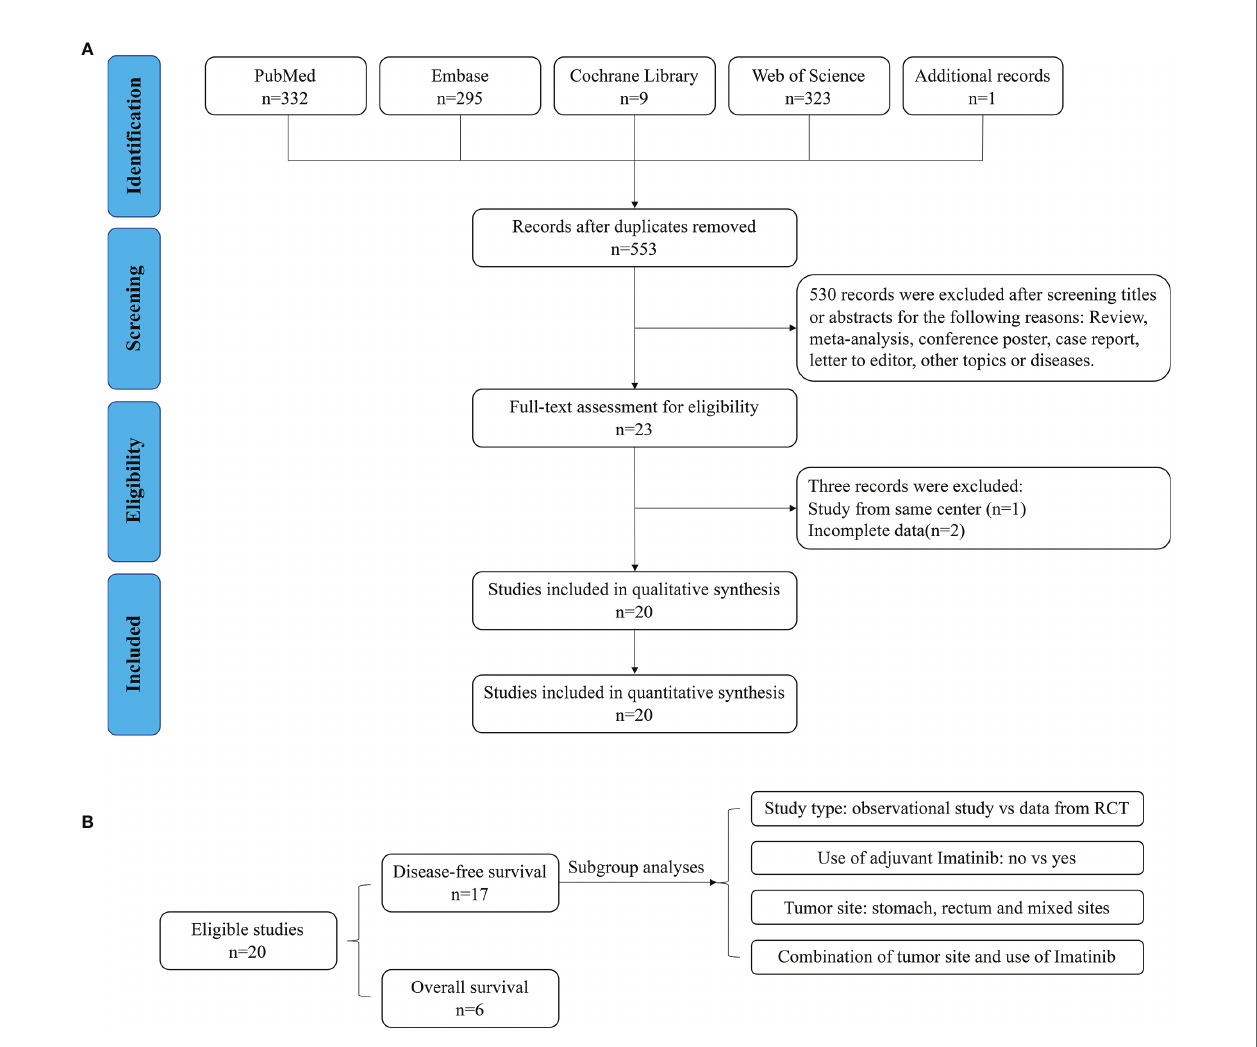
FIGURE 1 | Flow chart of (A) search strategy and (B) study